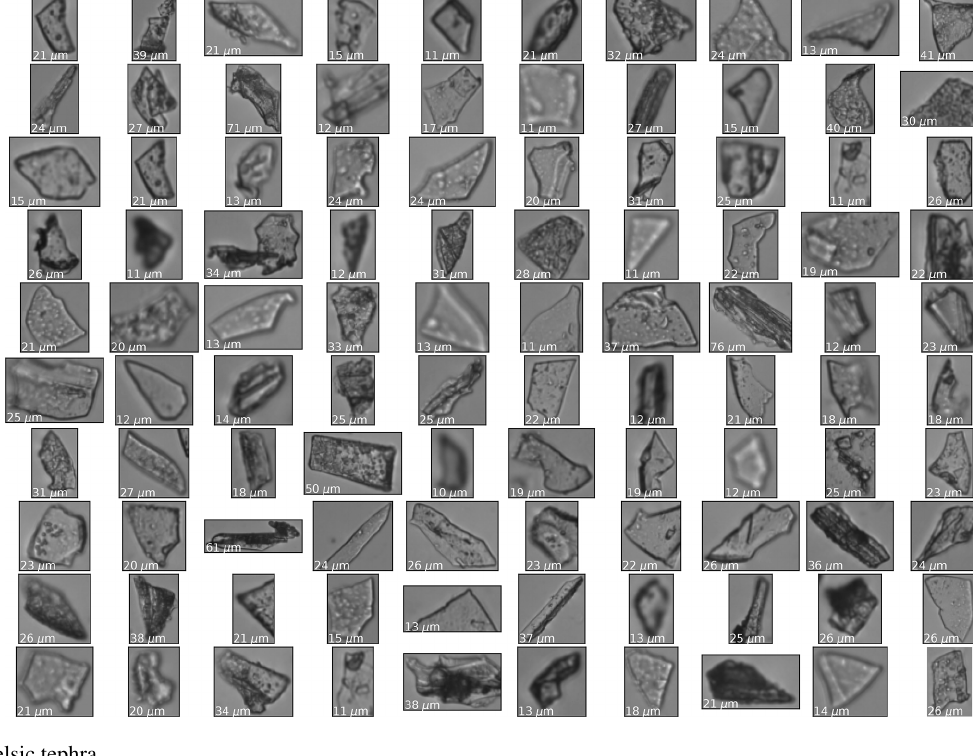
Figure C2. Felsic tephra.